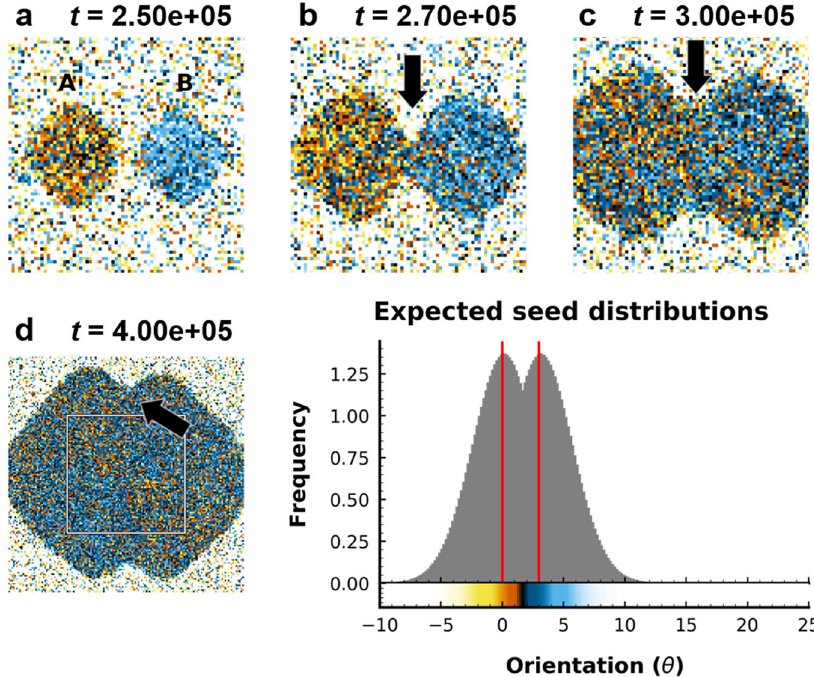
Fig. 6 Growth of two FCC grains with 3° misorientation. Growth at a 2.50 × 10 5 , b 2.70 × 10 5 , c 3.00 × 10 5 , d 4.00 × 10 5 timesteps. a – c Frames from early stages of growth are cropped to show more detail. The area cropped is shown by the white outline in d . e shows the colorbar for this fi gure, where alignment with seed A corresponds to yellow-orange and alignment with seed B corresponds to blue color. Here, the gray peaks represent the expected probability density functions (PDFs) for reference grain ( θ = 0°) and the misoriented grain ( θ = 3°). The colorbar is cropped from the maximum range of orientation ( – 10° to ~ 80°) for clarity. Black area indicates angles along the shortest arc between 0° and the misoriented seed, and white areas correspond to angles along the longest arc between 0° and the misoriented seed. GB grooves are present during all stages of growth for both orientations, despite rotation of both grains to 0° misorientation (see arrows in b – d ). Although we observe global rotation of misoriented grains toward 0° misorientation, a persistent grain-boundary groove suggests unresolved phonon strain along the grain boundary due to incommensurate distances between FCC